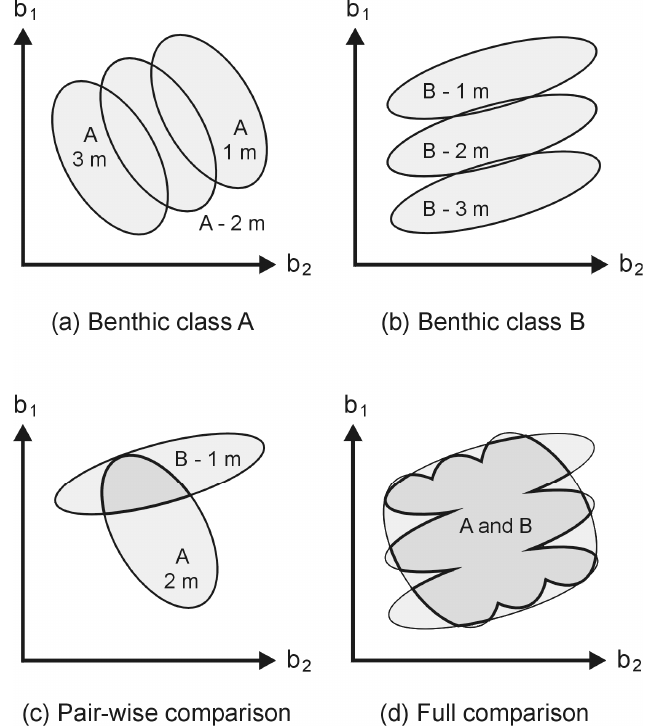
benthic classes across a depth range. Above water reflectance measured in two bands (b1, b2) shows the basic within-class variance in in situ reflectances of two benthic classes (A and B) shifted at the specific depths 1, 2 and 3 m, ( a ) and ( b ). Any pair-wise comparison between A and B at two specific depths indicates high separability ~65% ( c